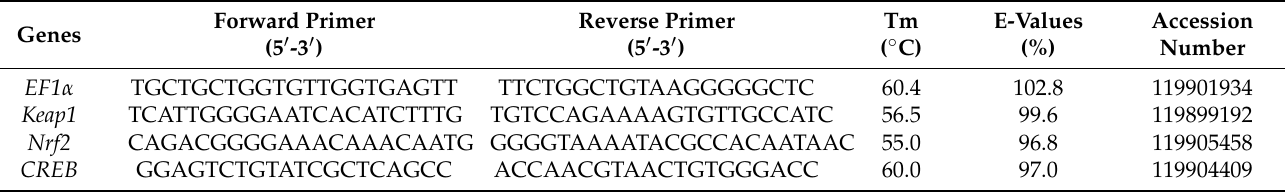
Table 3. Primer sequences for